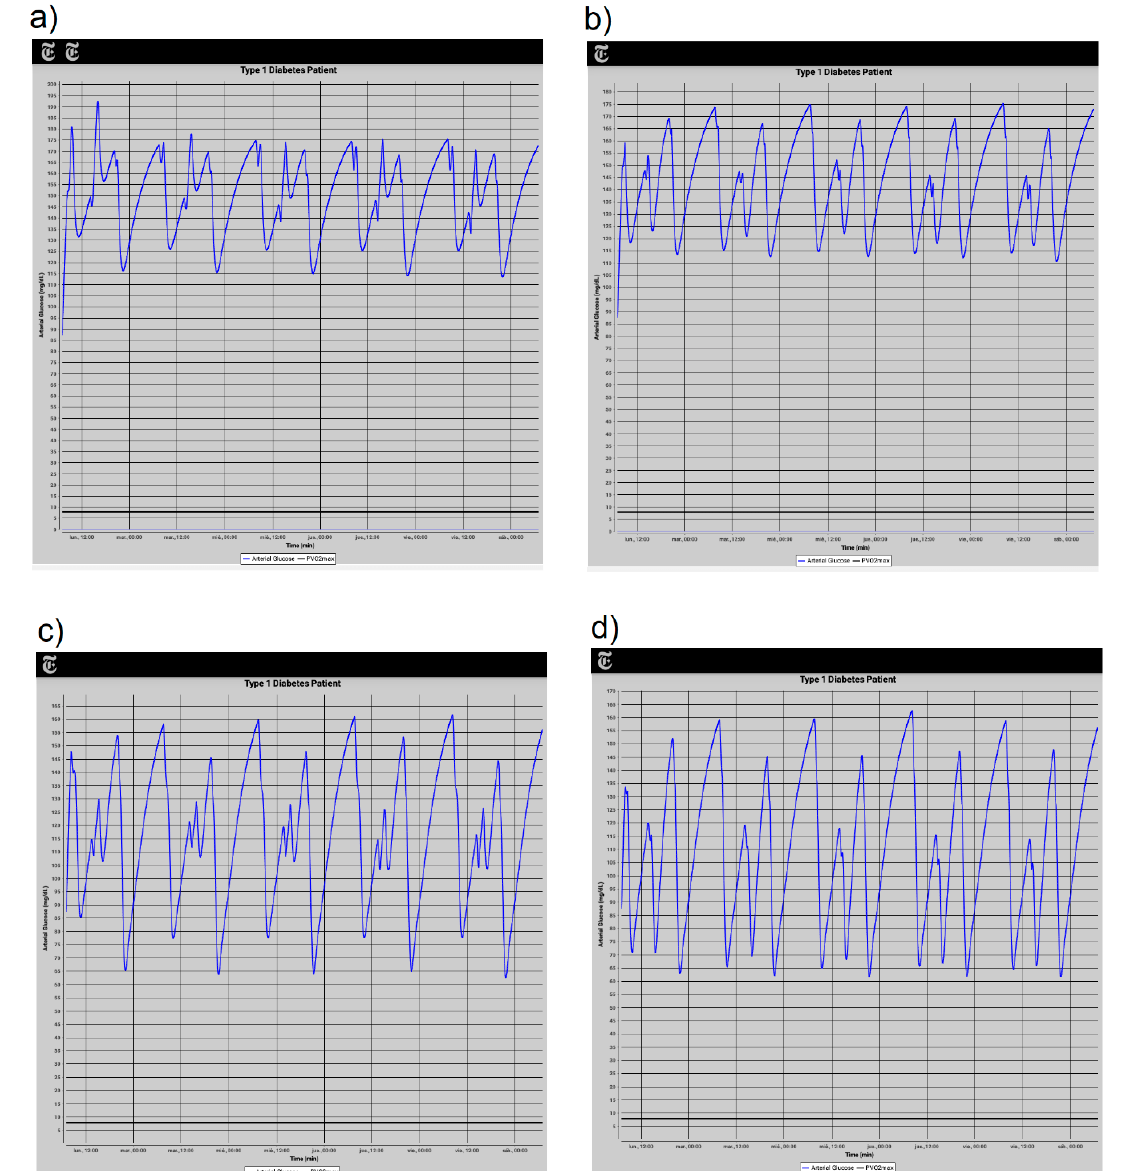
Figure 5. Comparison of blood glucose plots generated by AEDMA application for several values of carbohydrate grams and insulin units. ( a ) Experiment 1. ( b ) Experiment 2. ( c ) Experiment 3. ( d ) Experiment 4.